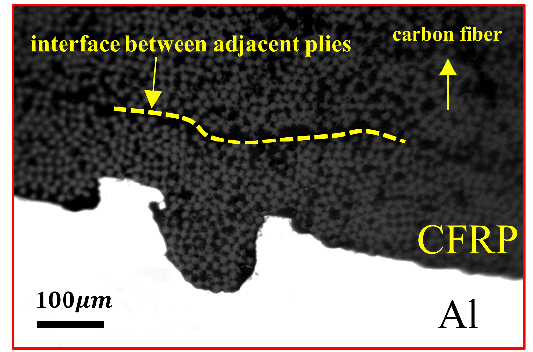
Figure 5. Microstructure of laminate A intercalation and nick.